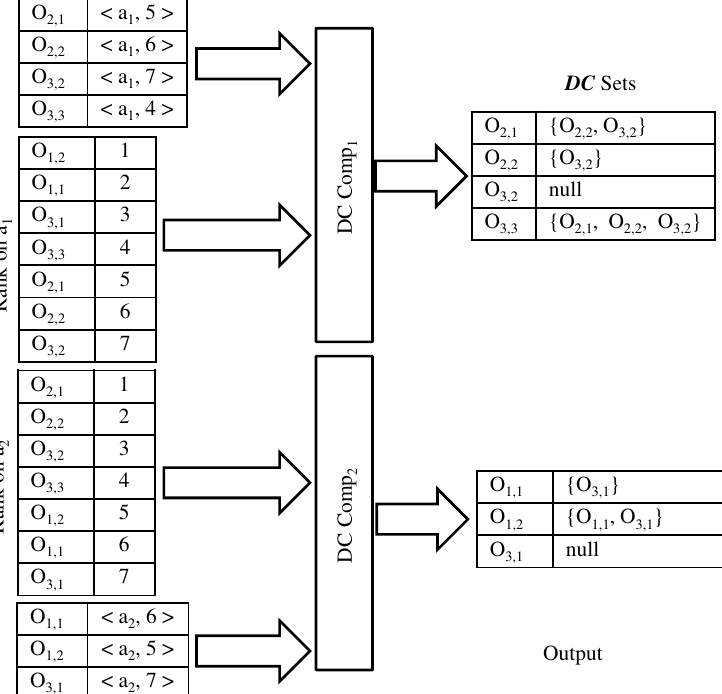
Figure 6. Domination check ( DC ) sets computation